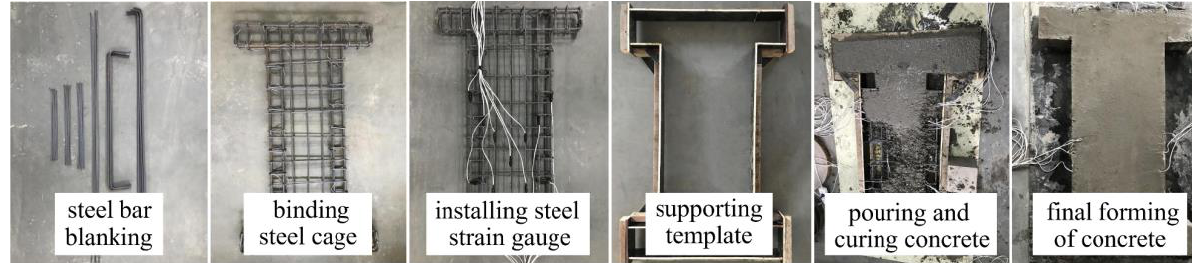
Figure 2. The specimen preparation process. Table 1. Parameters of the specimens.